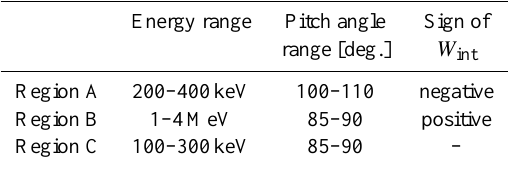
Table 1. Definition of Regions A, B, and